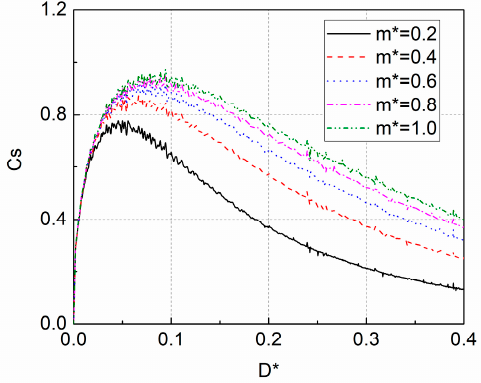
Figure 18. Variations of the non-dimensional impact force with di ff erent